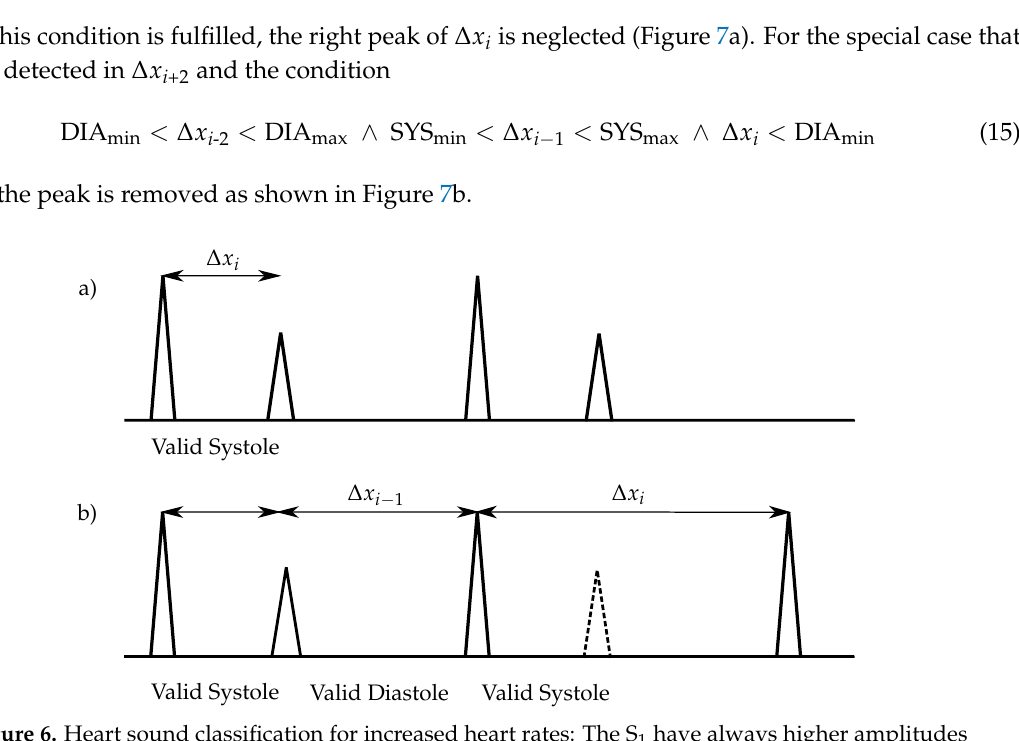
Figure 6. Heart sound classification for increased heart rates: The S 1 have always higher amplitudes than the S 2 . ( a ) No S 2 is missing; ( b ) One S 2 is missing (dashed lines).